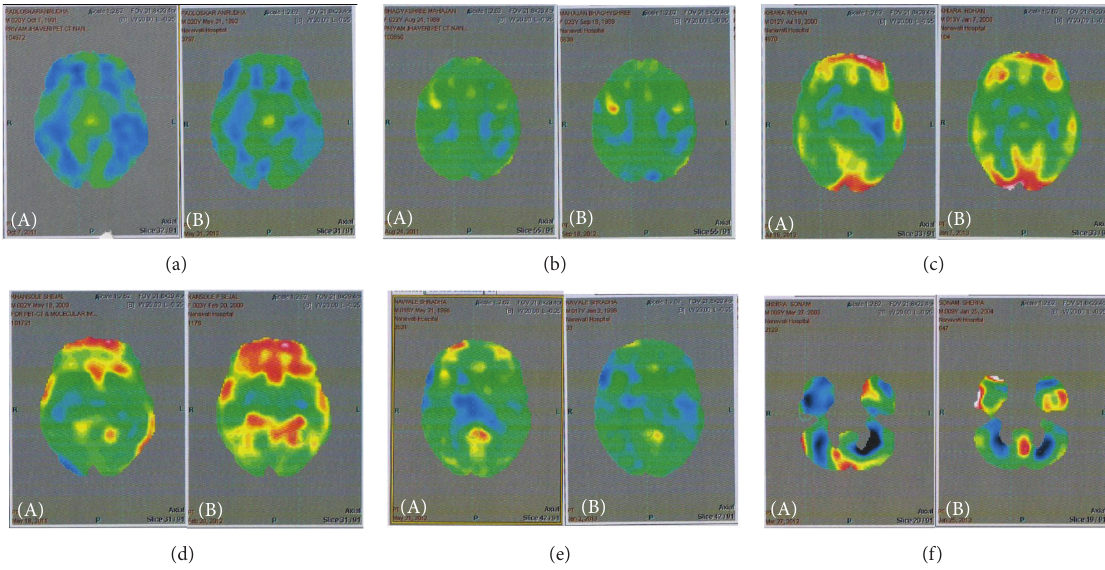
Figure 4: Improvements in PET-CT scan brain: PET-CT scan images of (A) pre- and (B) postintervention showing increased metabolic activity in various areas. Blue areas indicate hypometabolism, green areas indicate normal metabolism, yellow areas indicate slightly high metabolism, and red areas indicate high metabolism. Table 3: Number of patients showing improvements based on the GMFCS levels of the patient six months after intervention. GMFCS levels Mild improvements Moderate improvements Major